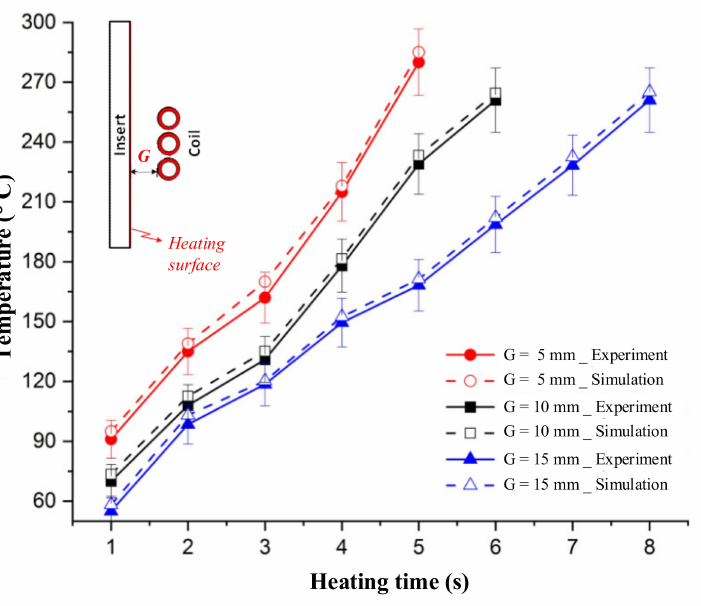
Figure 10. Comparison of temperature history at point O between experiment and